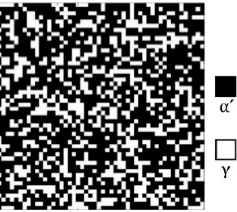
Figure 15. 2D RVE model of the 304L steel containing 64% α′ .